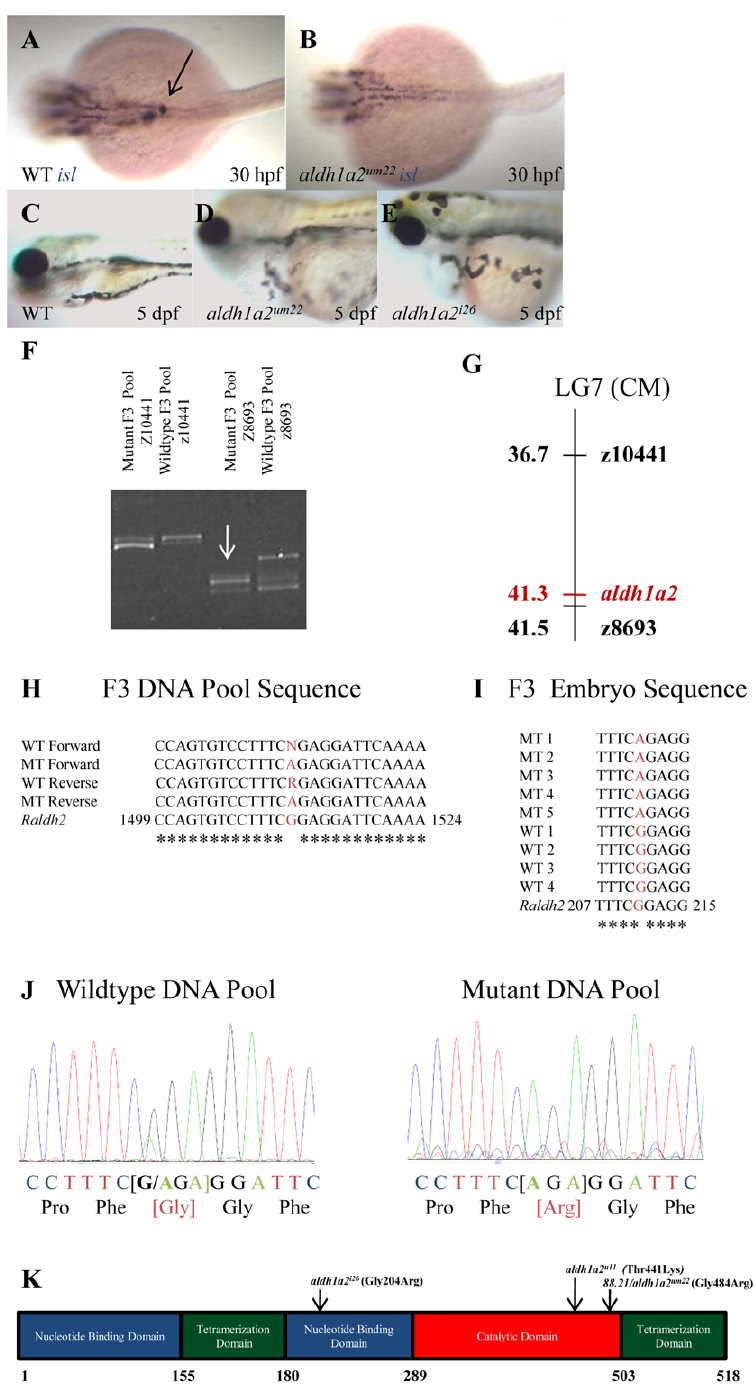
Figure 1. 88.21 is a novel aldh1a2 allele. A, B. Islet1 ( isl1 ) expression was used in a haploid ENU screen to identify mutants in endocrine pancreas development. Dorsal view of 30 hpf wild type embryo with isl1 expression in the CNS and endocrine pancreas (A; black arrow indicates expression in pancreas) and 88.21 mutant embryo with isl1 expression in the CNS, but not in the endoderm (B). C–E. Lateral view of live wild type (C), 88.21 (D), and neckless aldh1a2 i26 (E) embryos at day 5. F. Linkage analysis using CA repeat markers on pooled genomic DNA from 88.21 mutants and pooled genomic wild type DNA. Marker z10441 amplifies a 450 bp band and a faint 500 bp band in the mutant pool compared to a faint 450 bp band and a 500 bp band in the wild type pool. Marker z8693 amplifies two bands at 250 bp and 300 bp in the mutant pool compared to 250 bp, 300 bp as well as a 400 bp band in the wild type pool. White arrow points to lack of 400 bp band in mutant. G. Schematic drawing of part of linkage group 7 (LG7), showing the location of z10441 and z8693 and aldh1a2 (in red) in reference to these markers. H–J. Sequence analysis of pooled 88.21 mutant (MT) genomic DNA and pooled wild type (WT) genomic DNA (H, J), as well as of individual mutant (MT) and wild type (WT) embryos (I). 88.21 fish carry a mutation that converts Gly 484 to Arg (in red, and outlined in brackets in J) located in the catalytic domain. K. Schematic of Aldh1a2 protein and the location of the aldh1a2 mutant alleles aldh1a2 i26 , aldh1a2 u11 and 88.21/aldh1a2 um22 .